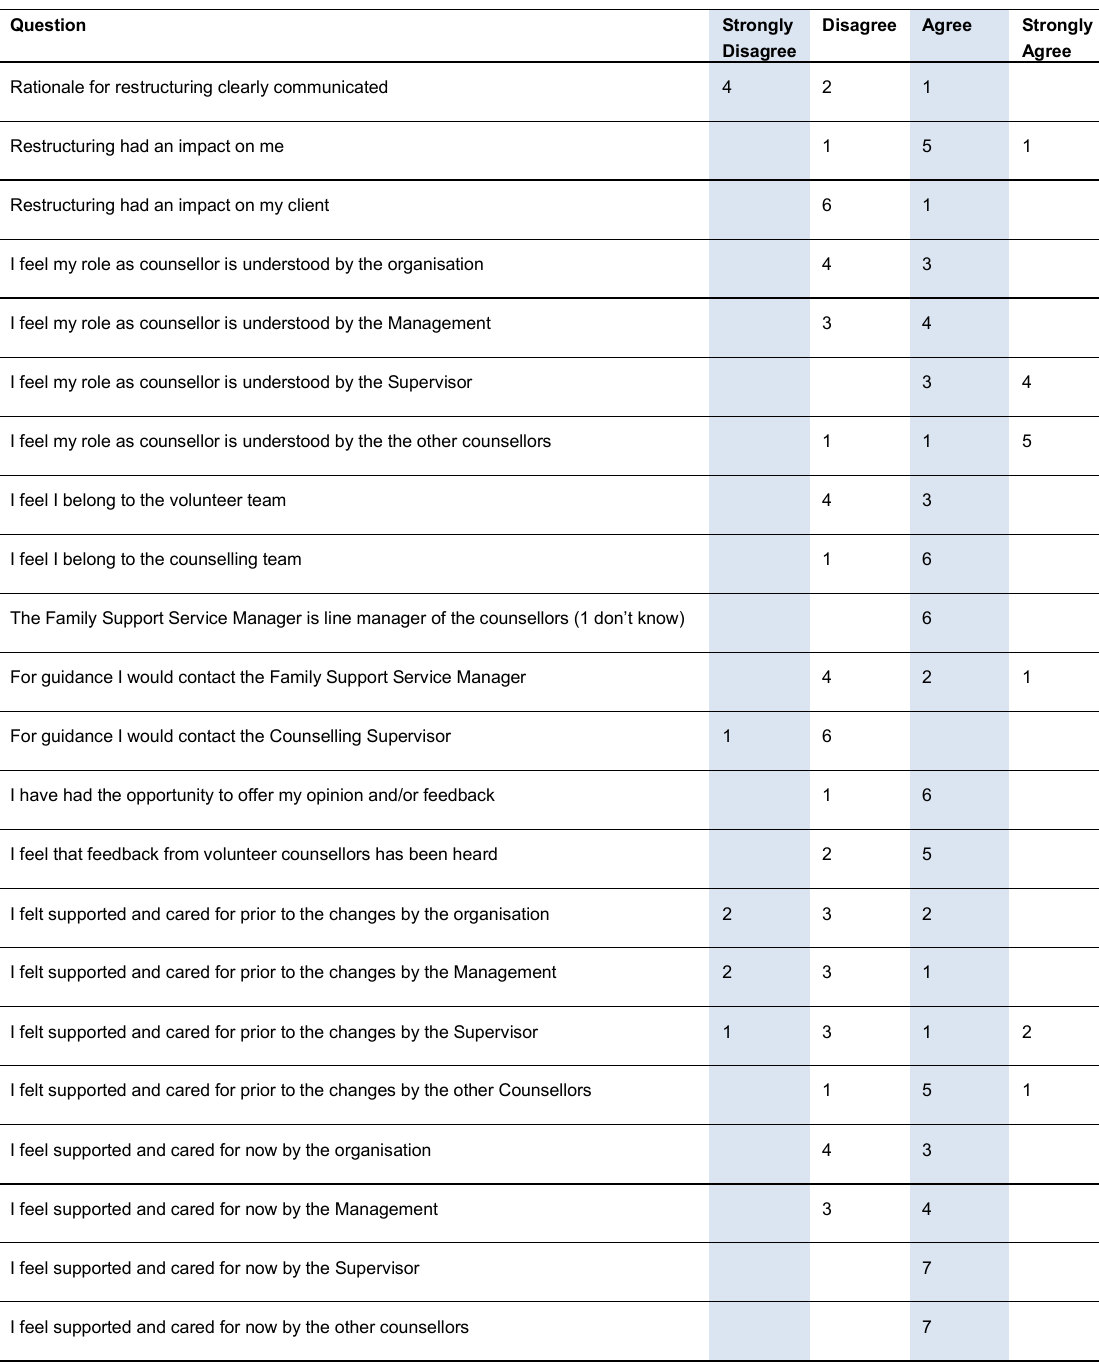
Table 1: Questionnaire